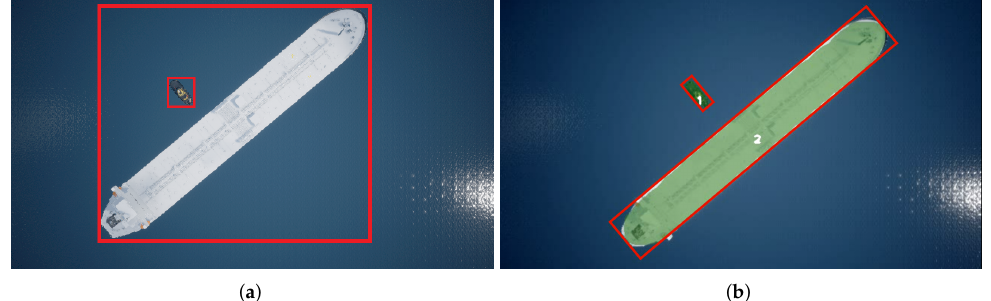
Figure 3. ( a ) Axis-aligned bounding boxes where the bounding boxes of two ships intersect. ( b ) A rotated bounding box computed from pixel-level segmentation (and the corresponding segmentation masks superimposed on top of both ships), that allows representing vessel’s spatial location more accurately and avoid bounding box intersections (figure reproduced from